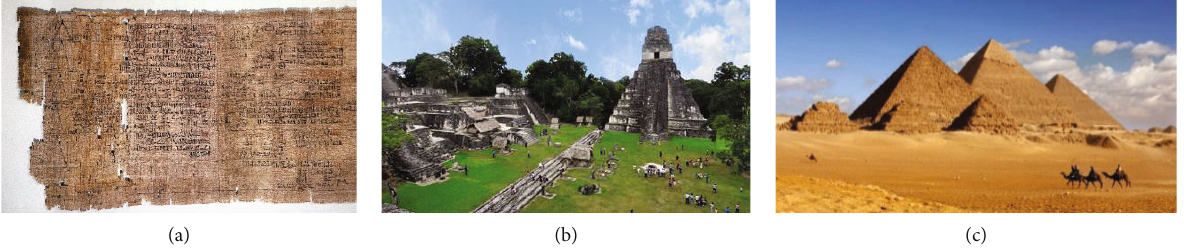
Figure 1: (a) The Rhind Mathematical Papyrus [5], (b) Aztec Maya [1], and (c) Pyramid in Egypt [6].